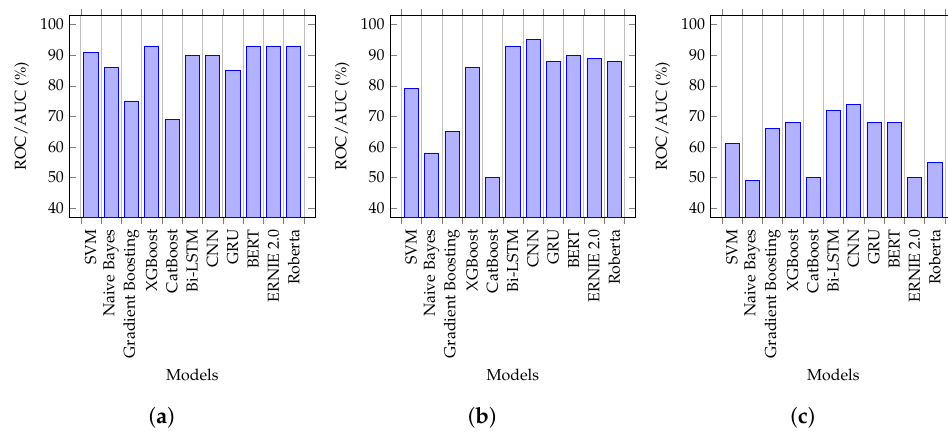
Figure 7. Quantitative ROC/AUC results across ( a ) Agency_records, ( b ) Employee_records, and ( c ) Customer_records for state-of-art methods.